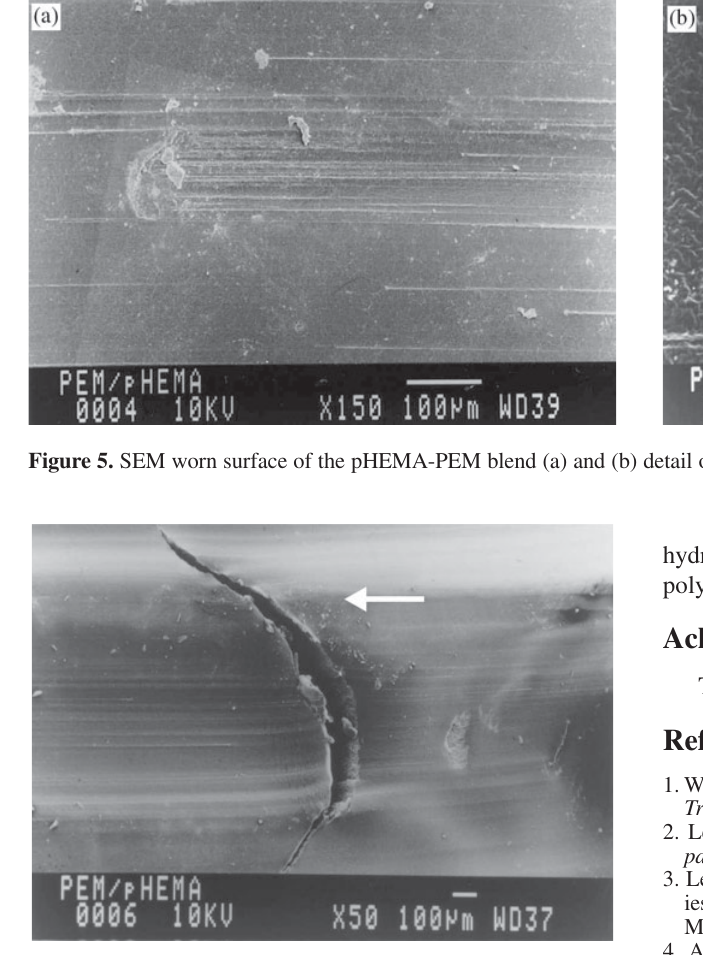
Figure 6. SEM of the pHEMA-PEM blend worn surface. The ar- row indicates the direction of the movement of friction sliding.